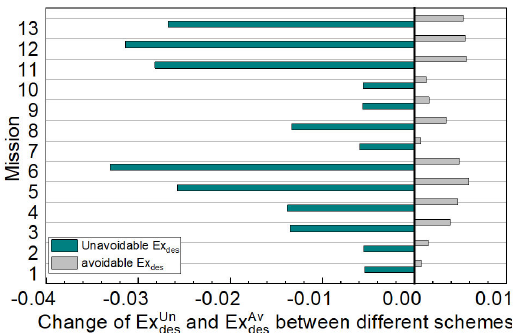
Figure 12. The comparison of avoidable and unavoidable exergy destruction between different